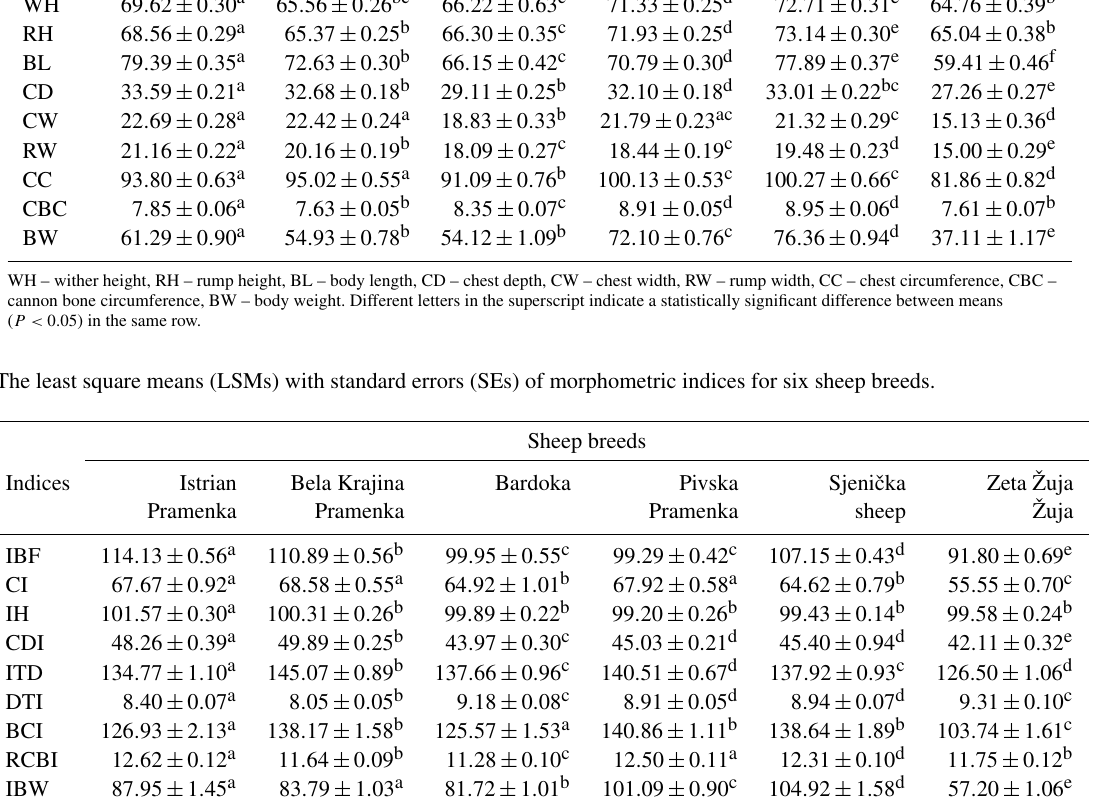
Table 1. The least square means (LSMs) with standard errors (SEs) of body measurements (cm) and body weight (kg) for six sheep breeds. Type of